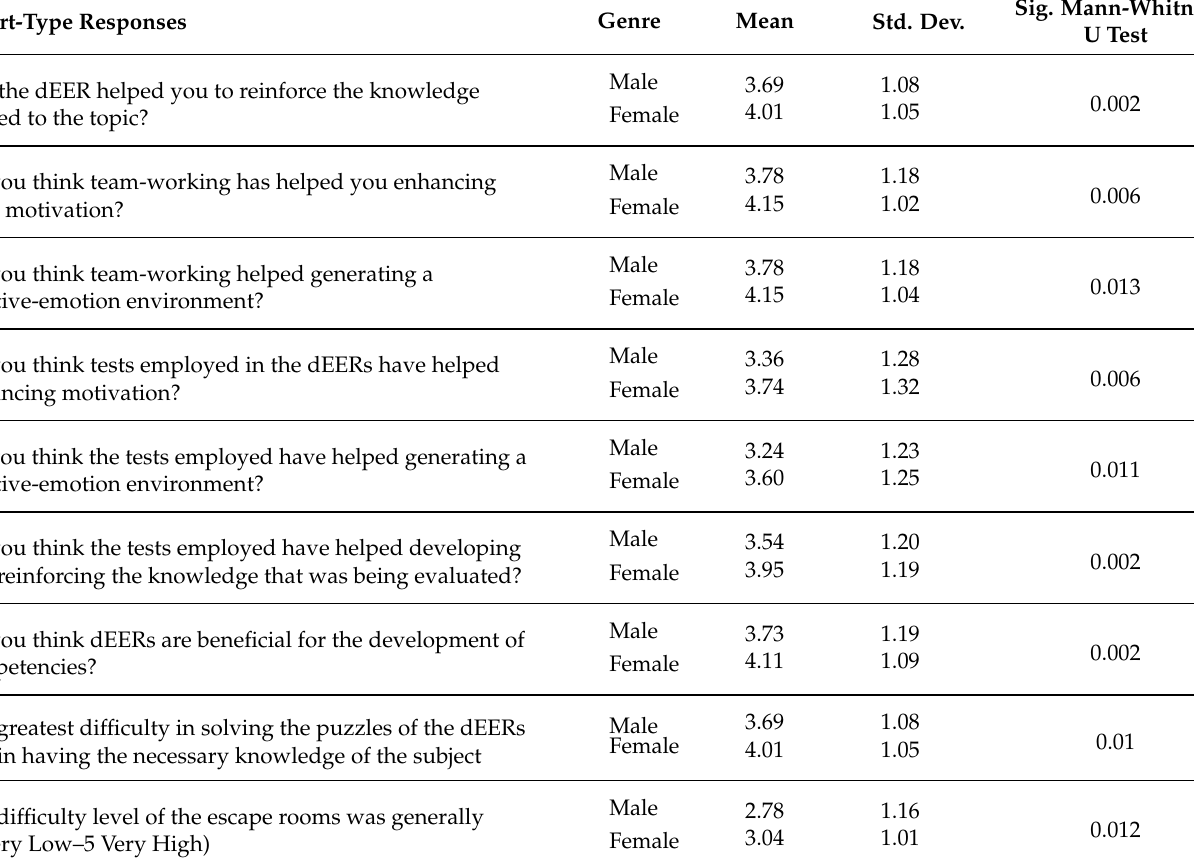
Table 6. Responses to Likert-type questions vs.